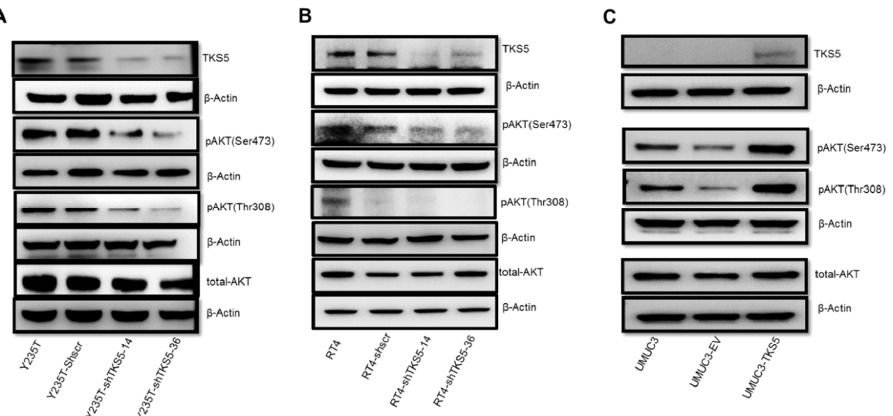
Figure 9. TKS5 is involved in AKT pathway activation in Y235T, RT4 and UMUC3 cells. ( A ) Protein levels of phospho-AKT (Ser473), phospho-AKT (Thr308) and total-AKT in Y235T parental, Y235T- shScramble and Y235T-shTKS5 cells. ( B ) Protein levels of phospho-AKT (Ser473), phospho-AKT (Thr308) and total-AKT in RT4 parental, RT4-shScramble and RT4-shTKS5 cells. ( C ) Protein levels of phospho-AKT (Ser473), phospho-AKT (Thr308) and total-AKT in UMUC3 parental, UMUC3 empty vector (EV) or UMUC3 with ectopic TKS5 cells. We used the same lysates and membranes to detect the target proteins (TKS5 and AKT) and internal reference protein ( β -actin). Please note that one ß-actin membrane served as the loading control for both pAKT targets. We repeated all the experiments three times with different lysates. The quantitation of the blots are presented in the supplemental data (Supplementary Figure